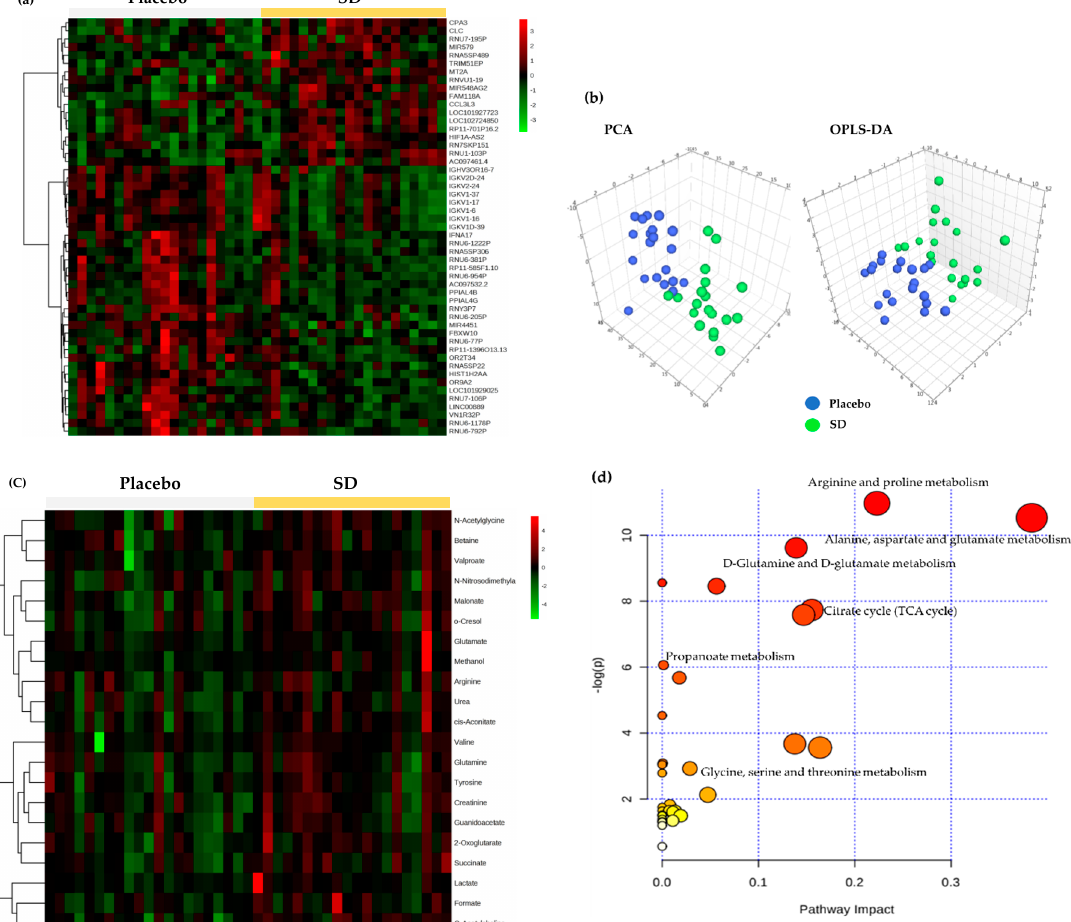
Figure 3. Changes in the PBMC transcriptome and urinary metabolome after placebo or high-dose SD (900 mg) consumption for 4 weeks: ( a ) heat map visualization for the PBMC transcriptome; ( b ) PCA and OPLS-DA score plots derived from urinary NMR metabolites; ( c ) heat map visualization for the urinary 1 H NMR metabolites; ( d ) metabolic pathway analysis overview showing altered urinary 1 H NMR metabolic pathways by SD consumption. PBMC, peripheral blood mononuclear cell; SD, Sanghuang–Danshen; PCA, principal component analysis; OPLS-DA, orthogonal partial least